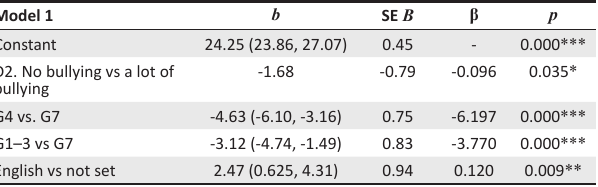
TABLE 4: Multiple linear regression with numeracy as outcome several categorical